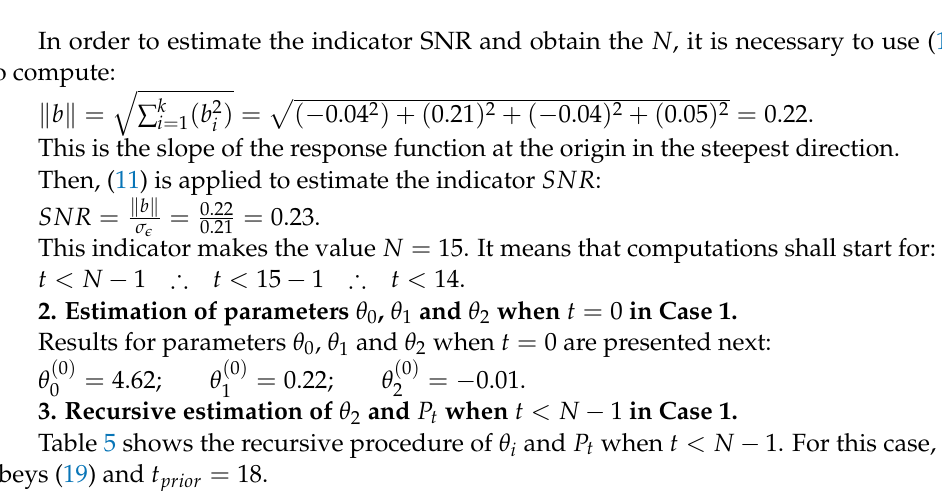
Figure 5. Graph with steepest ascent path of the response y with both straight and curved lines, which assumes both quadratic and non-quadratic behavior in Case